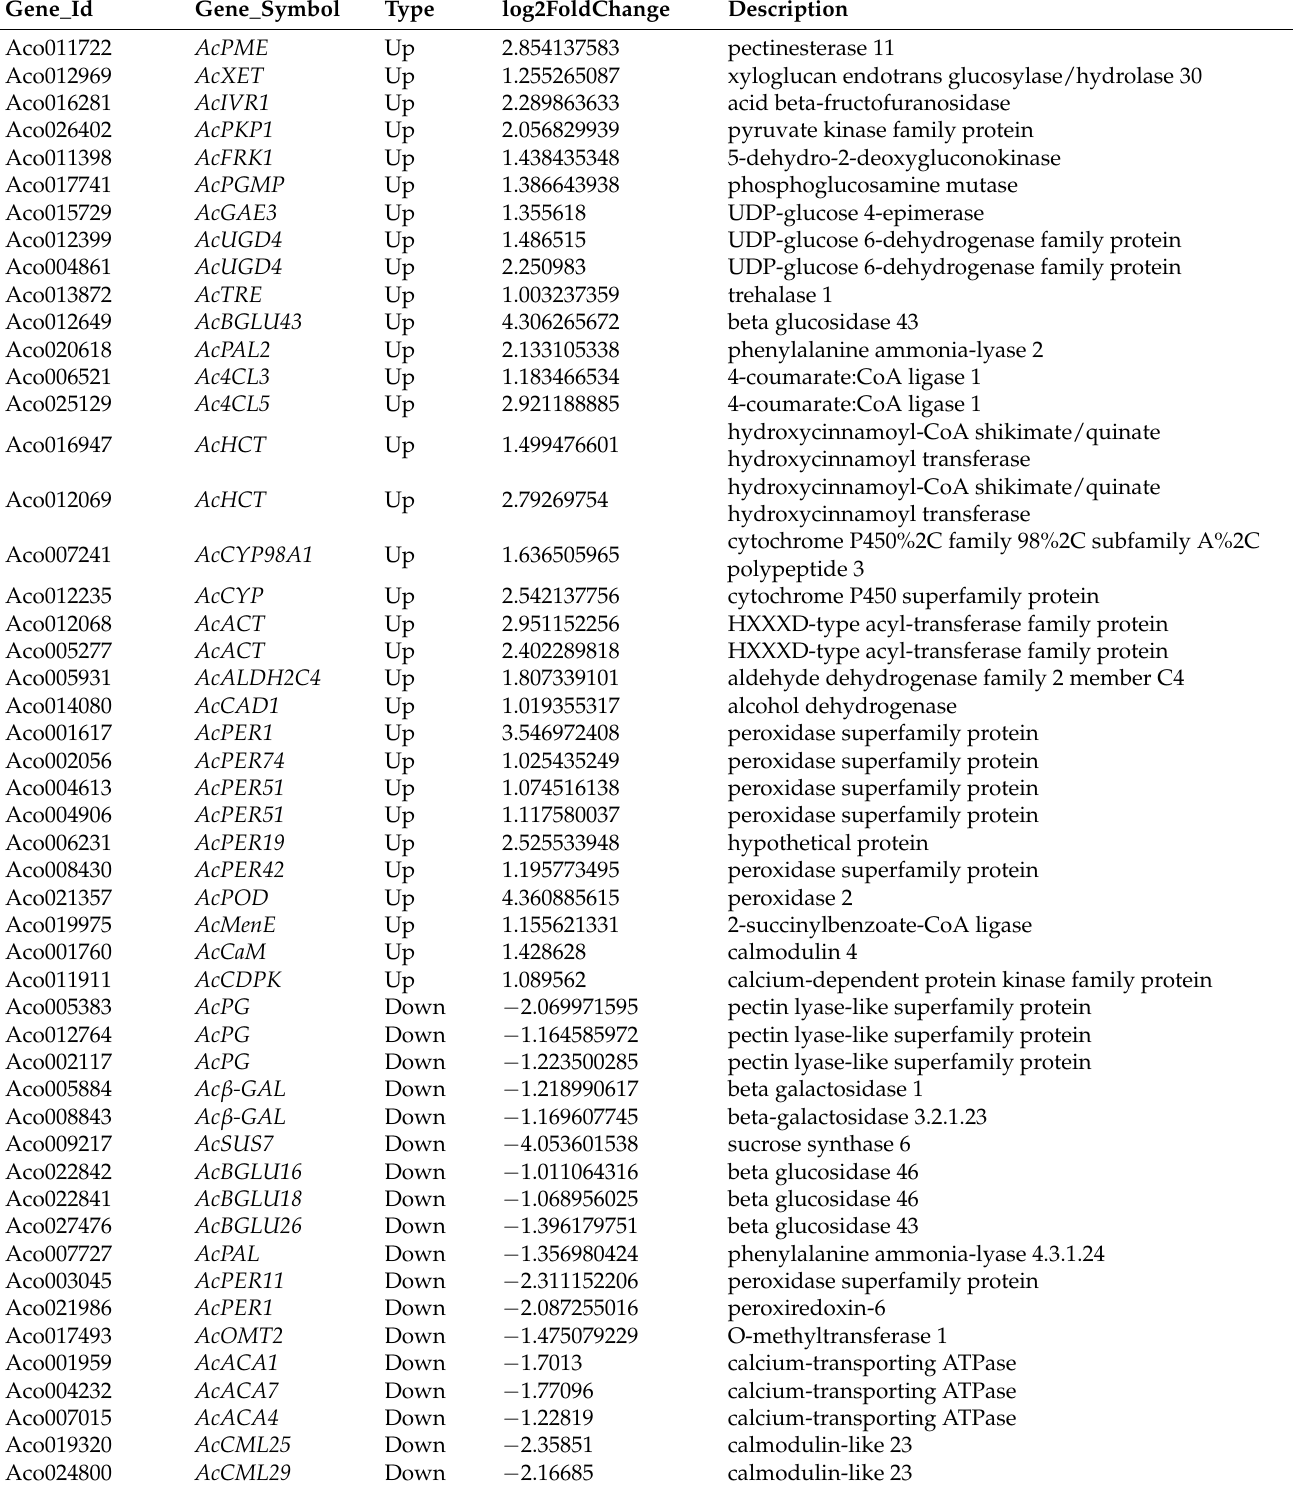
Table 2. Genes with different expression levels between MS and CK. Up, expression in MS > expression in CK; down, expression in MS < expression in